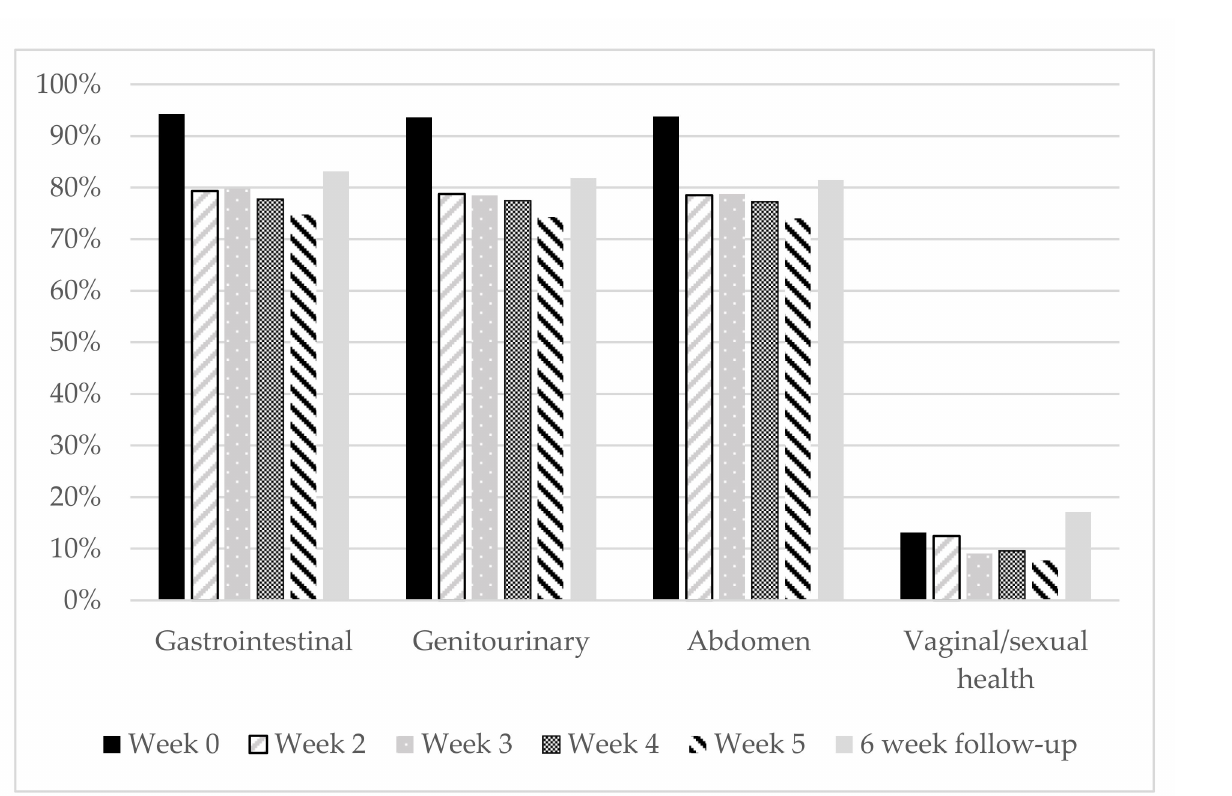
Figure 2. Domain response rates compared to baseline. Response was considered positive if ≥ 60 percent of the questions within that domain were